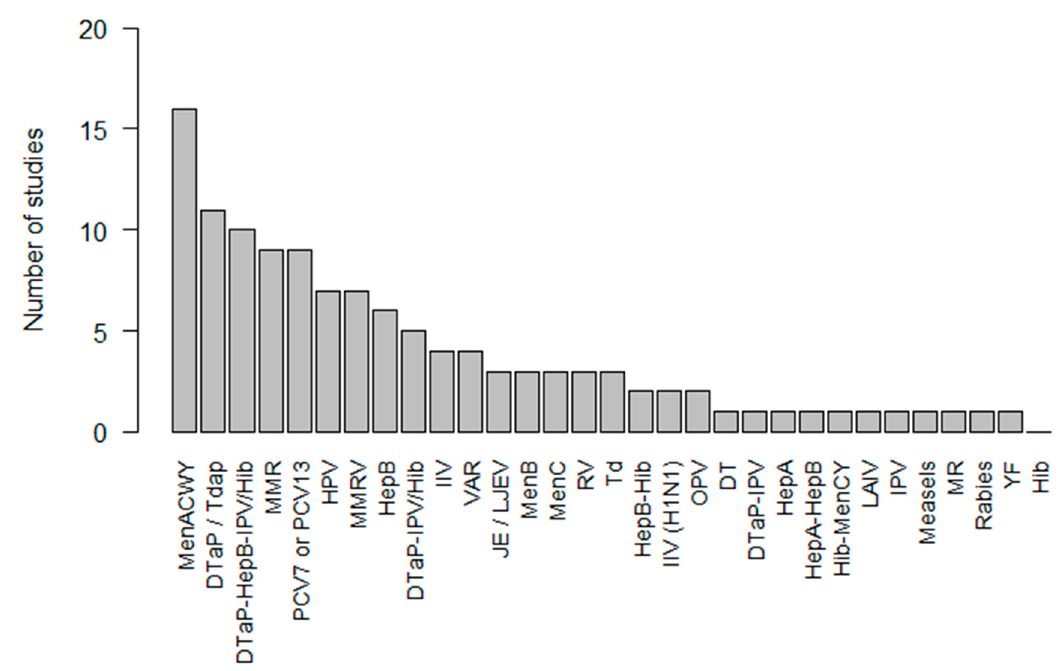
Figure 2. Frequency of vaccines investigated in co-administration versus separate administration studies.